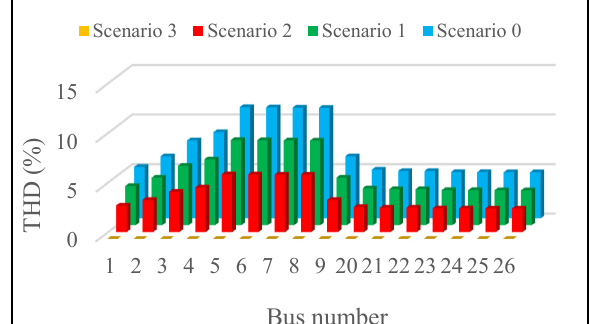
Figure 9. The THD value of network voltages when the SACAPF is located at bus 5, and the rating of the SACAPF is constrained (scenarios are defined in Table 3).